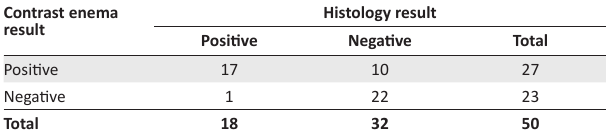
TABLE 1: Screening test evaluation: Single table